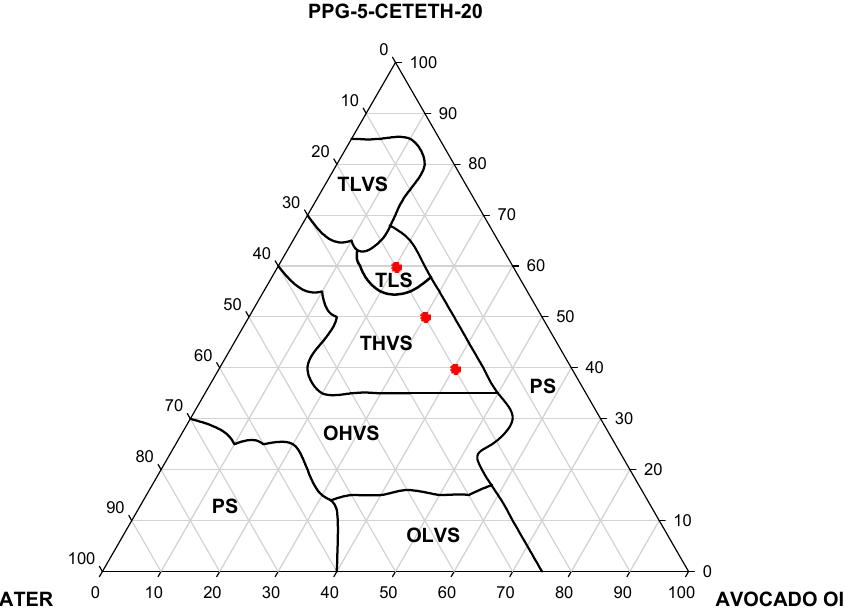
Figure 1. Ternary phase diagram (PPG-5-Ceteth-20, avocado oil and water): opaque low and high-viscosity systems (OLVS and OHVS), translucent low and high-viscosity systems (TLVS and THVS), transparent liquid system (TLS), and phase separation (PS) (the red circle indicates the formulations selected for further experiments). Table 1. Percentages of components of the formulations.